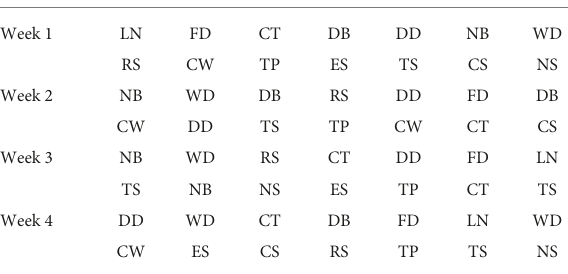
TABLE 1 The protocol of 28 days chronic unpredictable mild